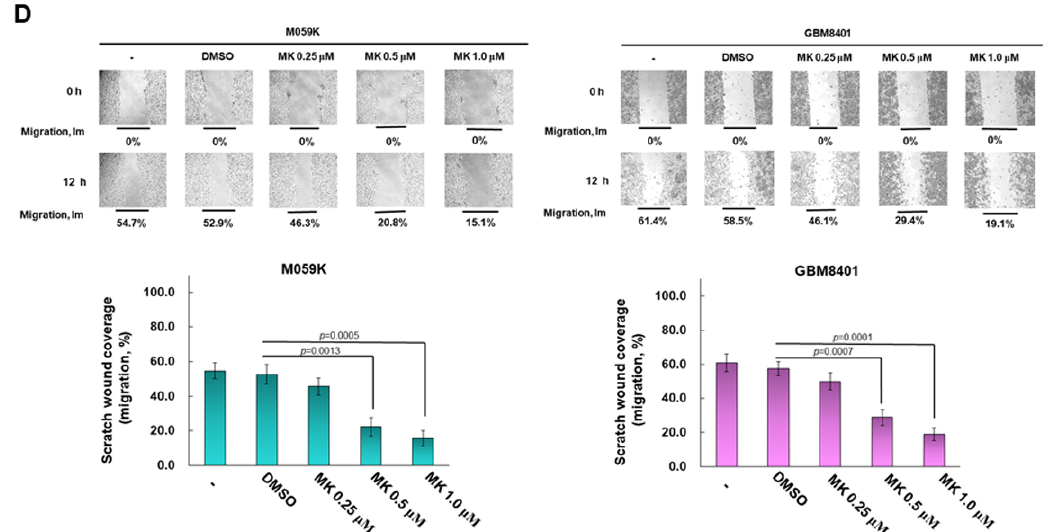
Figure 8. Maackiain (MK) treatment reduced the proliferation and migration of GBM cells. ( A ) M059K and GBM8401 cells were treated with 0.1, 0.25, 0.5, 1, 2, or 4 μ M MK for 24 h, and the cell survival rate was determined by MTT assay. Concentrations below 1 μ M MK did not significantly affect cell survival. ( B ) BCAS1-SV1 expression was analyzed by Western blotting. Anti-BCAS1 antibody was used to detect BCAS1 and BCAS1-SV1. β -actin was an internal control. ( C ) Proliferation of MK-treated M059K (left) and GBM8401 (right) cells was determined by CellTiter Blue Cell Viability assay. ( D ) Migration of MK-treated M059K (left) and GBM8401 (right) cells was determined by scratch wound assay. Bars, width of the initial scratch gap at the start of the experiment. A migratory index, Im, was defined as Im = (g0 − g12)/g0, where g12 and g0 are the gap widths at time 12 and time 0, respectively.